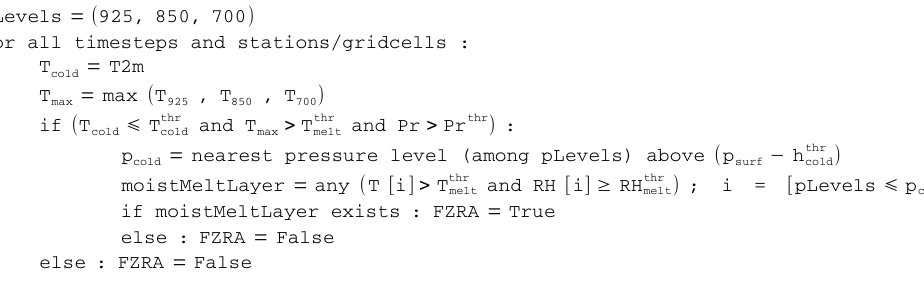
where B is the bias (Eq. A7). The logarithm scales B from −∞ to +∞ , the best, unbiased value being zero. Therefore biased solutions result a non-zero bias term that is then sub- tracted from CSI. Adjusted values used in the algorithm are presented in Table